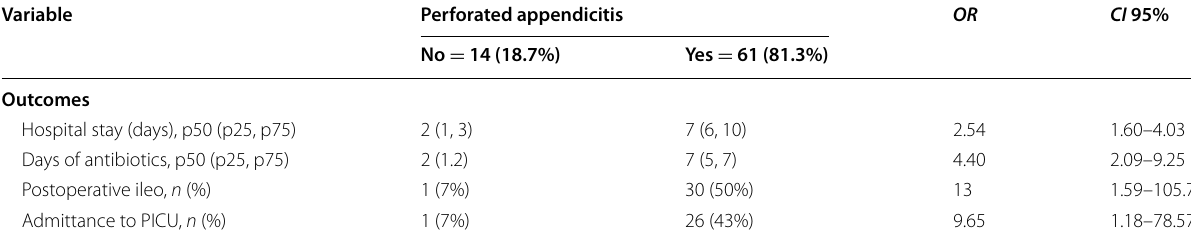
Table 4 Outcomes associated with perforation in acute appendicitis Variable Perforated